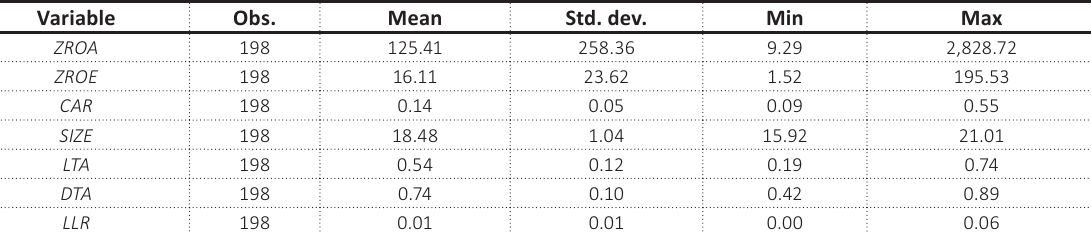
Table 2. Descriptive statistics of